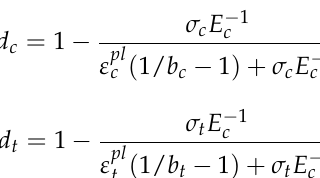
and 𝑑 ) were calculated based (cid:3030) (cid:3047)